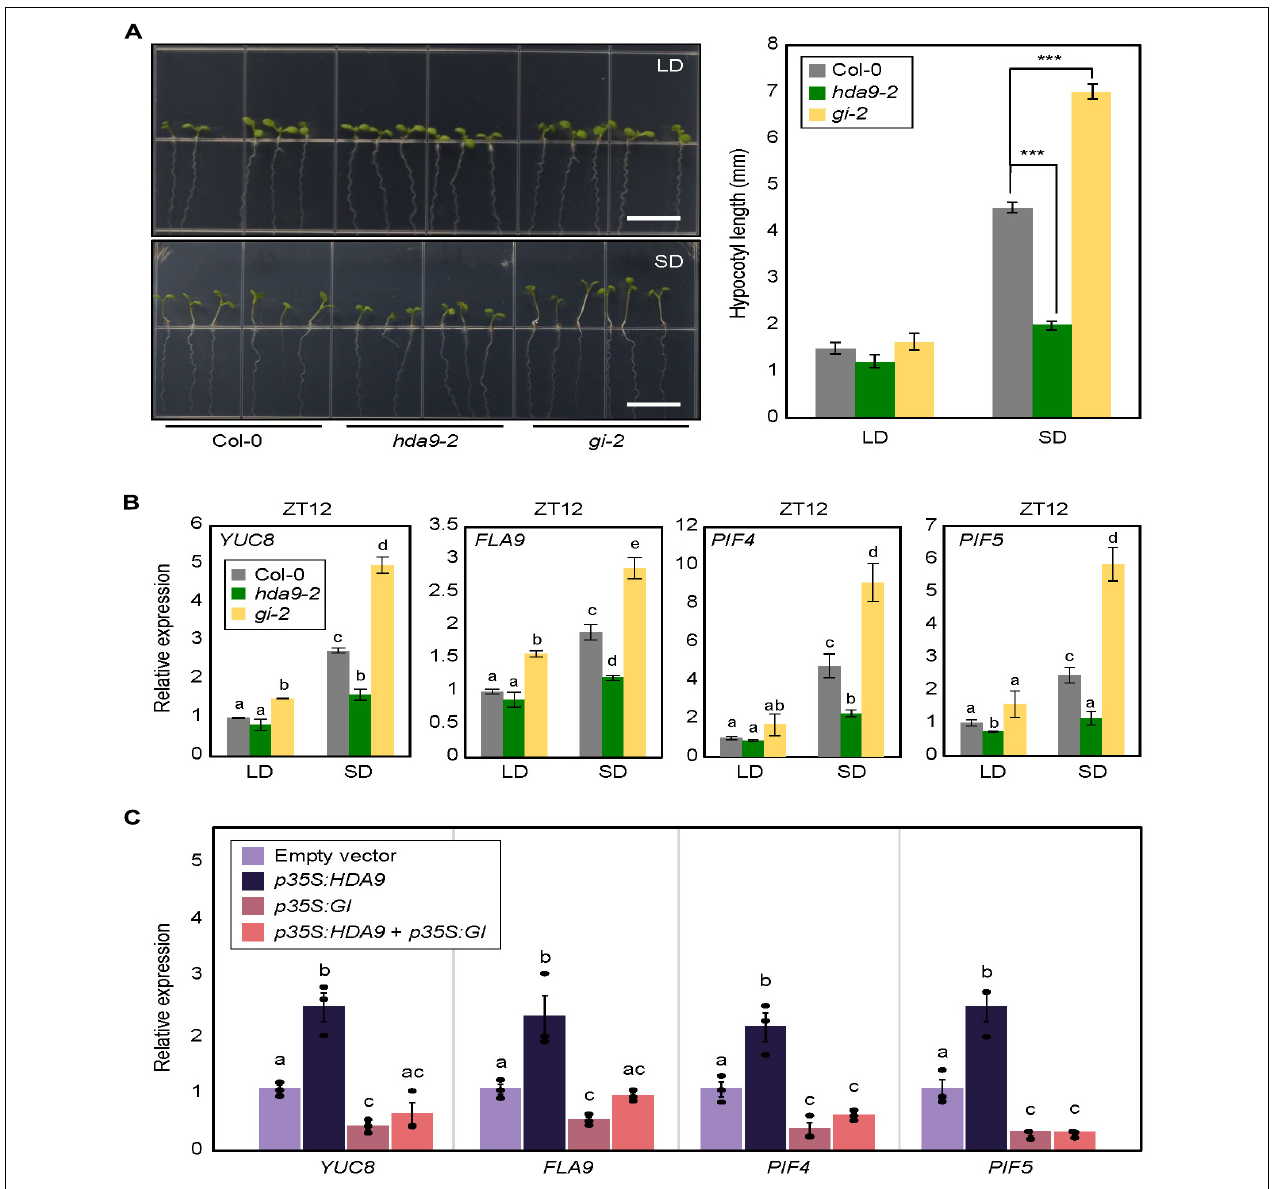
FIGURE 6 | Photoperiodic regulation of hypocotyl elongation in hda9-2 and gi-2 mutants. (A) Analysis of hypocotyl growth in hda9-2 and gi-2 mutants in short days (SDs). Seven-day-old seedlings grown under long day (LD) and short day (SD) conditions were photographed (left panel). Hypocotyl length was measured using the ImageJ software (right panel). At least 30 seedlings of each genotype were used to measure the hypocotyl length. Three biological replicates were averaged. Error bars indicate the standard error of mean (SEM). Statistical significance of the measurements was analyzed by Student’s t -test (*** P < 0.001). Scale bars = 1.0 cm. (B) Expression analysis of YUC8, FLA9, PIF4 , and PIF5 at ZT12. Transcript accumulation was measured by RT-qPCR. Three biological replicates were averaged. Error bars indicate the SEM. Different letters represent a significant difference at P < 0.05 (one-way ANOVA with Fisher’s post hoc test). (C) Expression of YUC8 , FLA9, PIF4, and PIF5 in protoplasts transiently overexpressing HDA9 and GIGANTEA ( GI ). Seven-day-old seedlings grown under SD conditions were used for protoplast isolation. The recombinant constructs were coexpressed transiently in Arabidopsis protoplasts, and then protoplast samples were harvested at ZT12 24 h after transfection to extract total RNAs. Transcript accumulation was determined by RT-qPCR analysis. Biological triplicates were averaged, and statistical significance of the measurements was analyzed by one-way analyzed by one-way analysis of variance (ANOVA) with Fisher’s post hoc test ( P < 0.05). Bars indicate the standard error of the